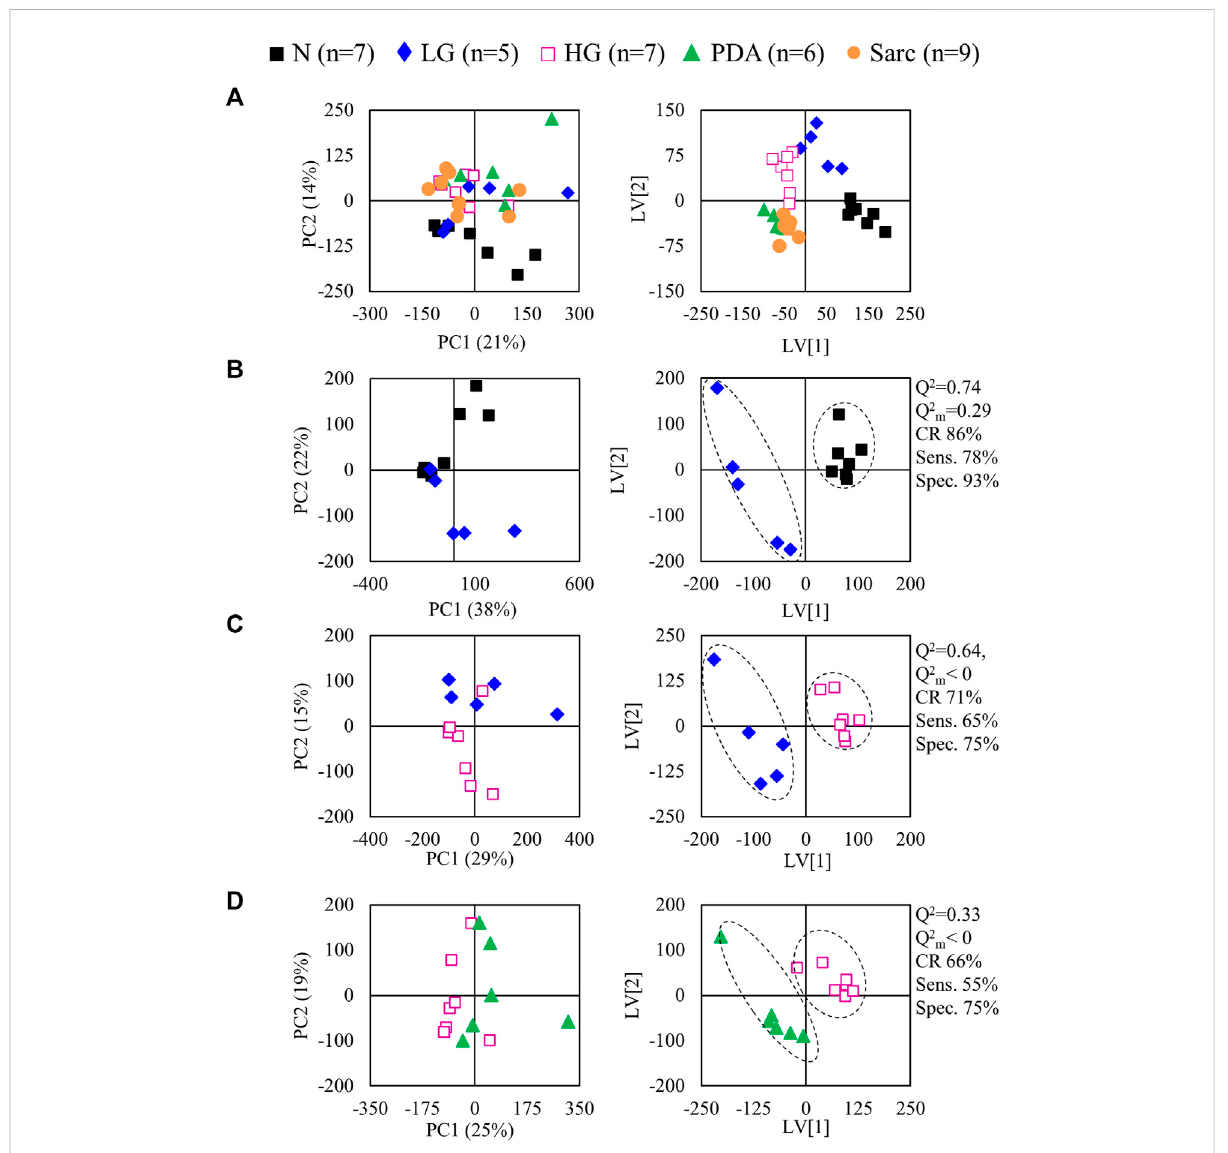
FIGURE 4 PCA (left) and PLS-DA (right) scores scatter plots for 1 H NMR spectra (normalized to total area) of (A) N, LG, HG, PSA and Sarc. classes, (B) N vs . LG, (C) LG vs . HG, (D) HG vs . PDA. Q 2 , predictive power of PLS-DA model; CR, classi fi cation rate; sens., sensitivity; spec., speci fi